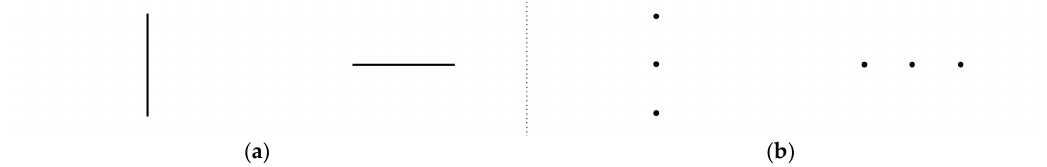
Figure 1. Representation of the different visual stimuli the rat was asked to distinguish: ( a ) On the left, the two signs standing for verticality and horizontality, which the rat was trained to recognize; ( b ) On the right, the newer stimuli, shown to the rat after the training. It is also interesting to notice how the orientation is only one of the several pertinences the signs are made of.